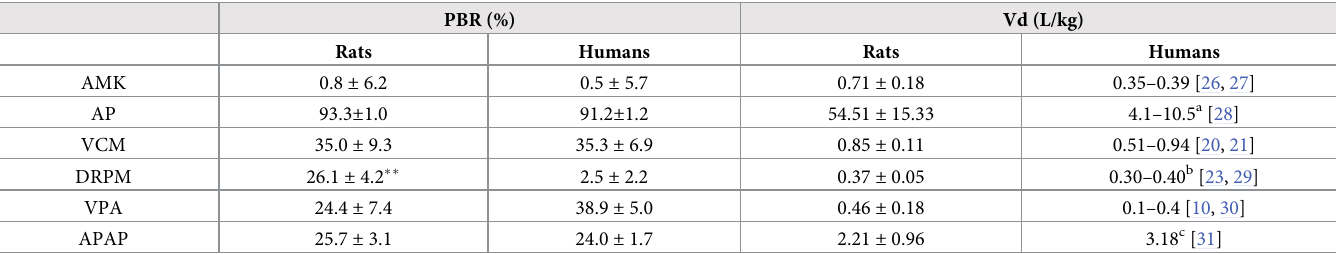
Table 4. PBR and Vd of various drugs between humans and in vivo rat